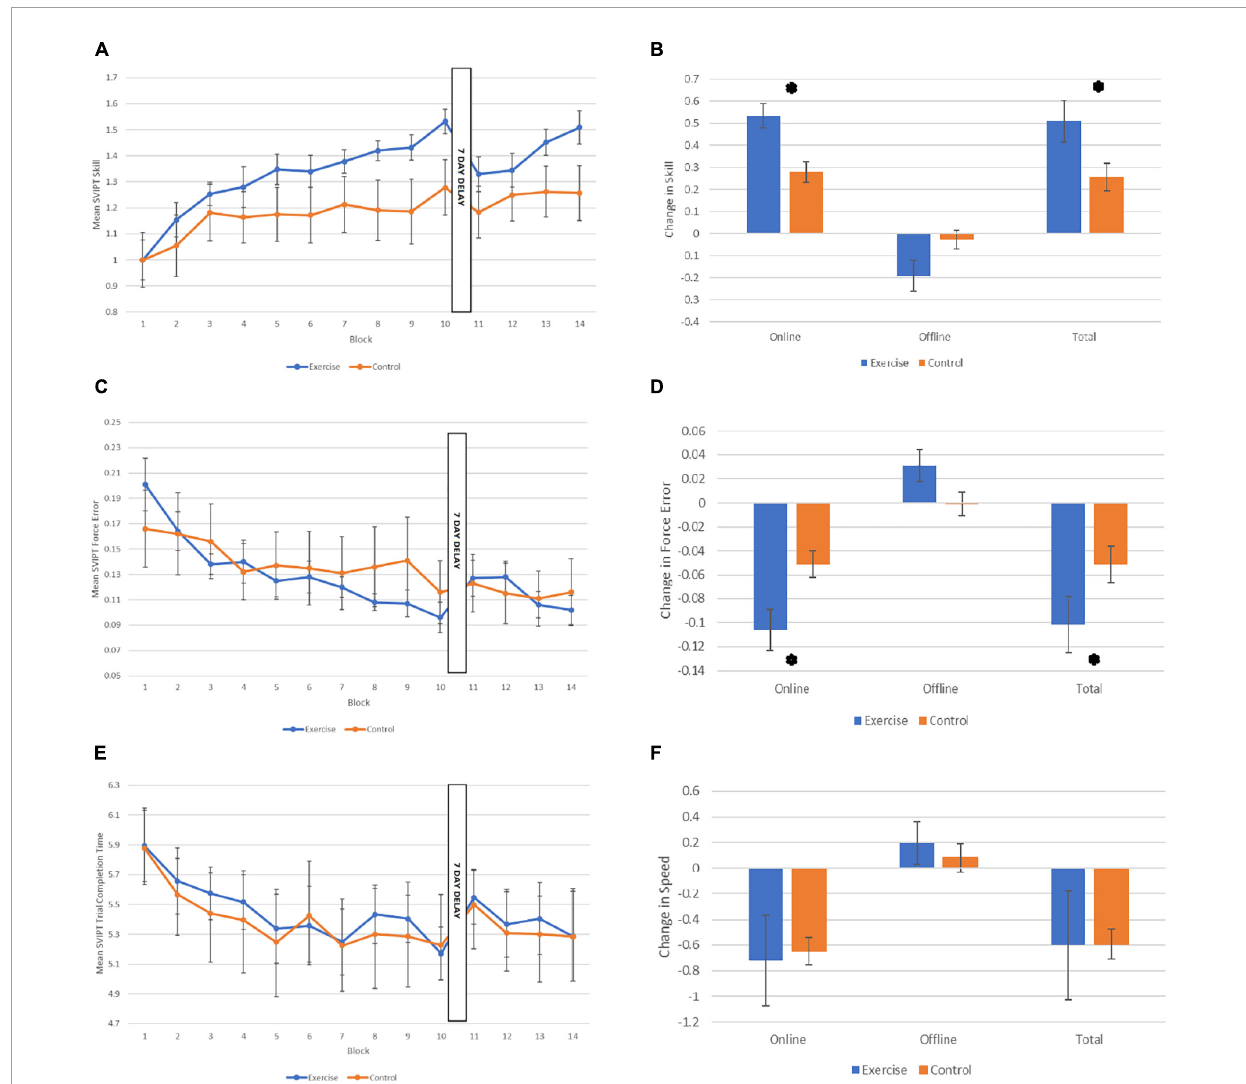
FIGURE2 Performance on the motor learning task across the two sessions. (A) Mean sequential visual isometric pinch task (SVIPT) skill score for each group for each of the 14 Blocks. (B) Skill change scores for each group: Online (from Block 1 to 10), offline (from Block 10 to 12), and total change in skill (from Block 1 to 14; normalized to Block 1). (C) Mean SVIPT force error (accuracy) score for each group for each of the 14 Blocks. (D) Force error change scores for each group: Online, offline, and total change in force error. (E) Mean SVIPT trial completion time (in secs) for each group for each of the 14 Blocks. (F) Speed change scores for each group: Online, offline, and total change in speed. All data are presented as M (SE). * p <